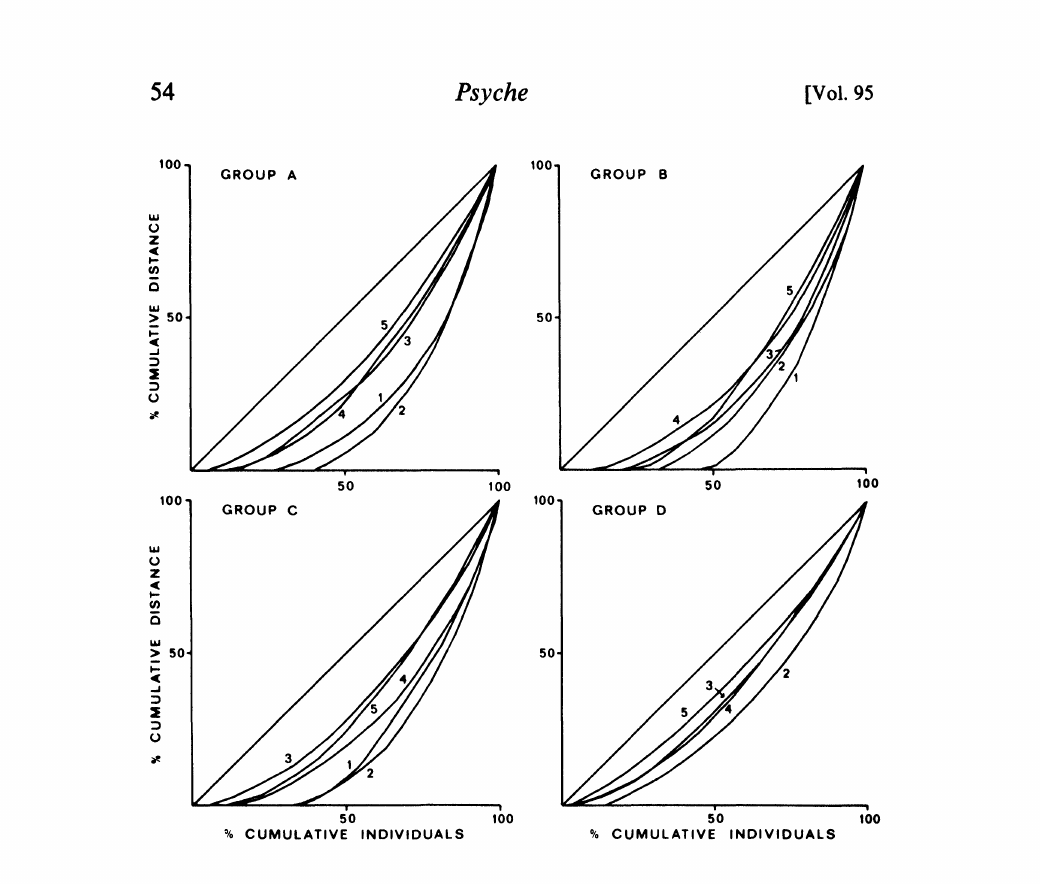
Figure 1. Pattern of inequality in distance traveled by individual larvae in sibling groups. Numbers adjacent to curves indicate the instar tested. Groups A, B, C and D are shown. First instar larvae of Group D were tested, but they remained aggregated and thus are not